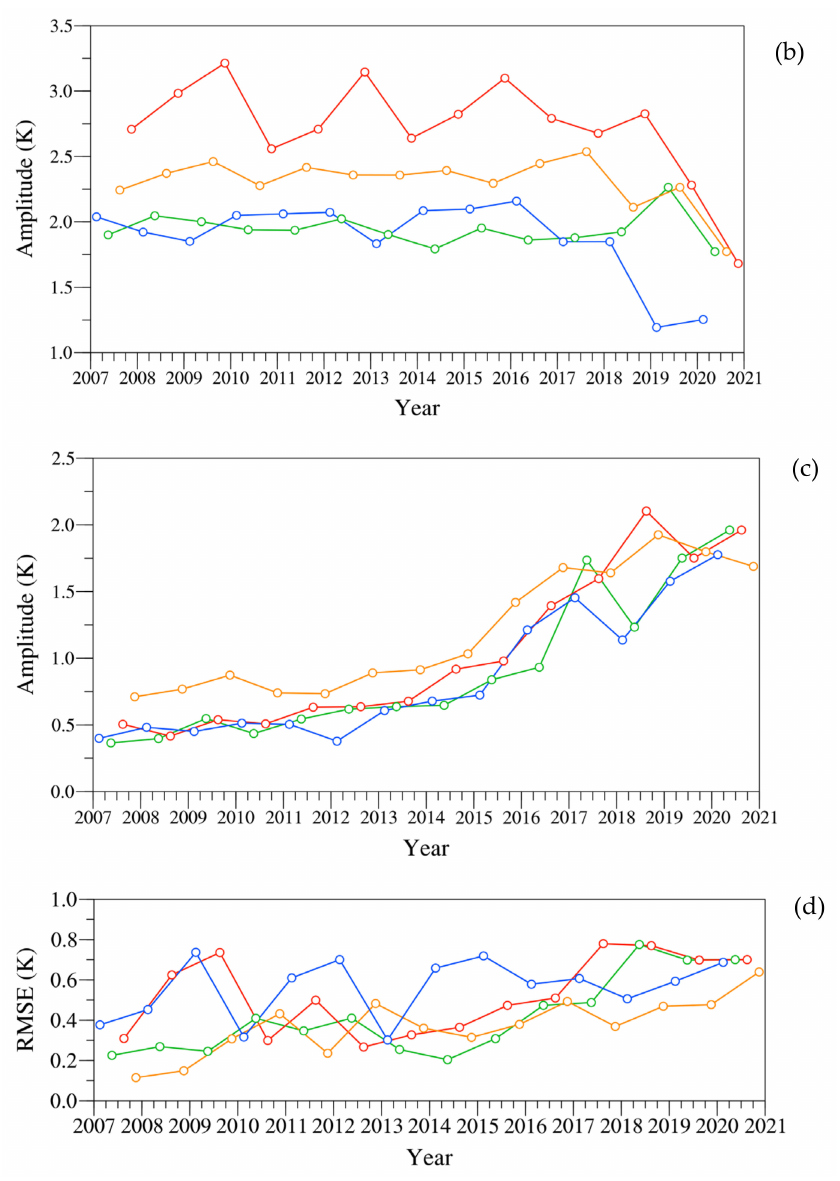
(cid:113) (cid:113) + B 2 + B 2 A 2 A 2 , ( c ) , and ( d ) mean-square-error (RMSE) 2 2 1 1